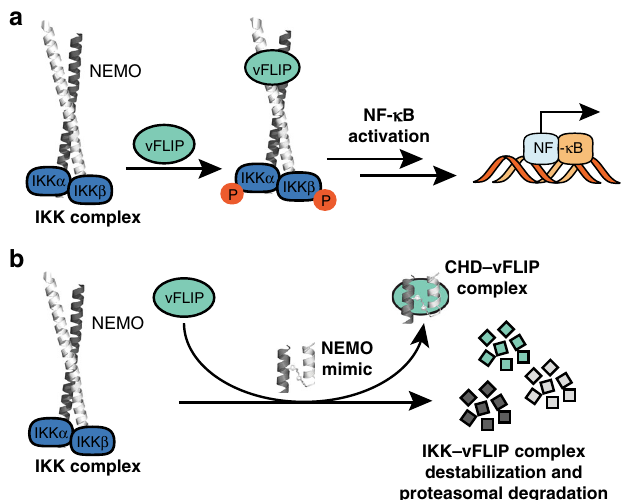
Fig. 7 Model for CHD3 NEMO mechanism of action. a vFLIP activates NF- κ B by engaging NEMO. b CHD3 NEMO (NEMO mimic) can directly bind vFLIP and compete with NEMO-vFLIP complex formation leading to destabilization of the IKK signalosome and inhibition of vFLIP-induced NF- κ B activation in PEL